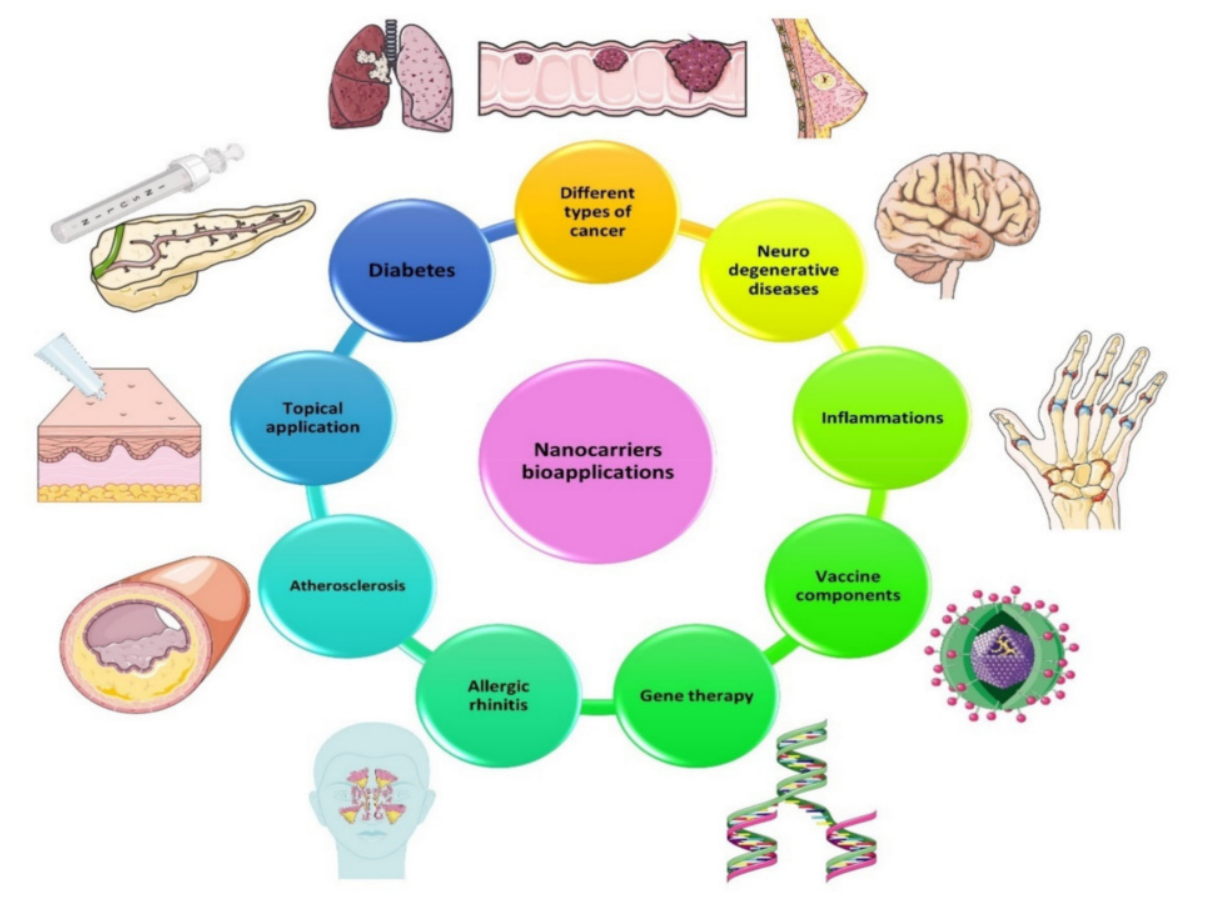
Figure 3. Different biomedical applications for nanocarriers.